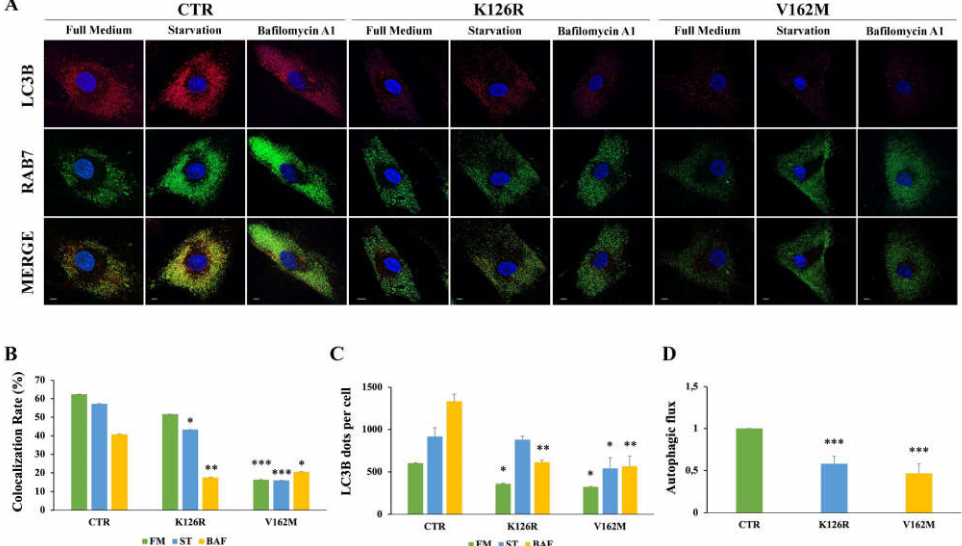
Figure 2. Analysis of autophagy in CMT2B fibroblasts by immunofluorescence. Control fibroblasts (CTR) and fibroblasts carrying K126R and V162M mutations were incubated with full medium (FM) or starvation medium (ST) for 30 min or incubated with 400 nM of Bafilomycin A 1 (BAF) for 3 h. ( A ) LC3B dots for cells and colocalization with RAB7 was evaluated by immunofluorescence using antibodies against LC3B (red) and RAB7 (green). Nuclei were stained with DAPI (blue). ( B ) Colocalization rate was analyzed for each condition (FM; ST and BAF) of the same sample. ( C ) The number of autophagosomes (scored as LC3B dots) per cell was evaluated for each sample. ( D ) The autophagic flux was calculated as the ratio of LC3B dots between BAF and FM of the same sample. Values are the mean ± SE of three different and independent experiments. * p < 0.05; ** p < 0.01; *** p < 0.0001. Scale bar = 10 µ